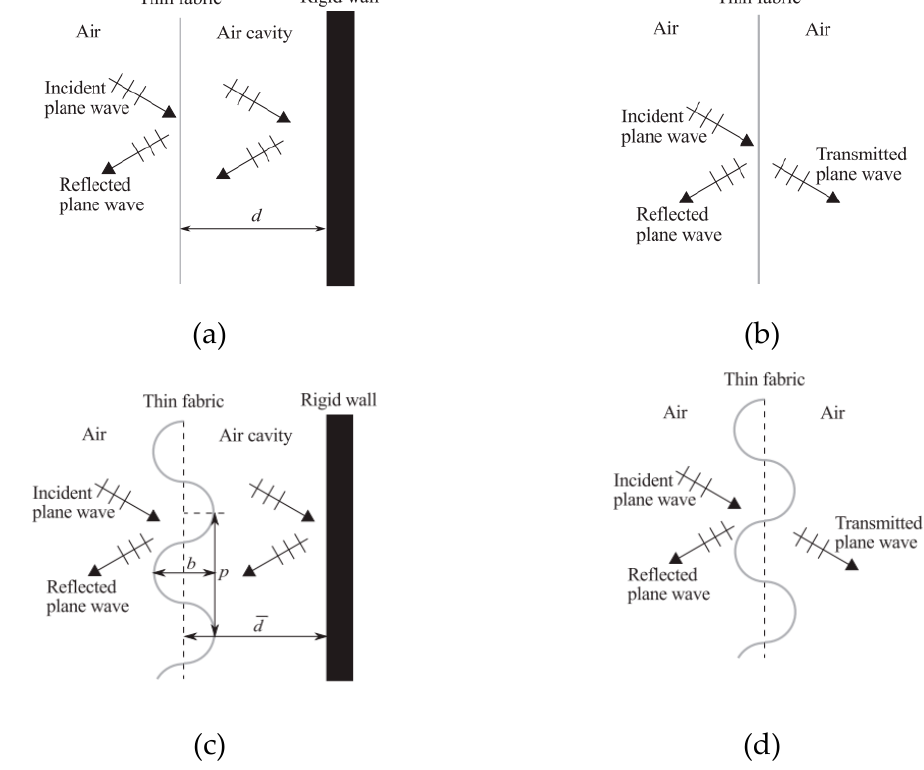
Figure 17. Textile curtains for sound insulation (reproduced from [105]). Sketch of ( a ) fabric sheet with rigid wall/window; ( b ) fabric sheet without air cavity; and folded thin curtain ( c ) with or ( d ) without rigid wall/window and air cavity.